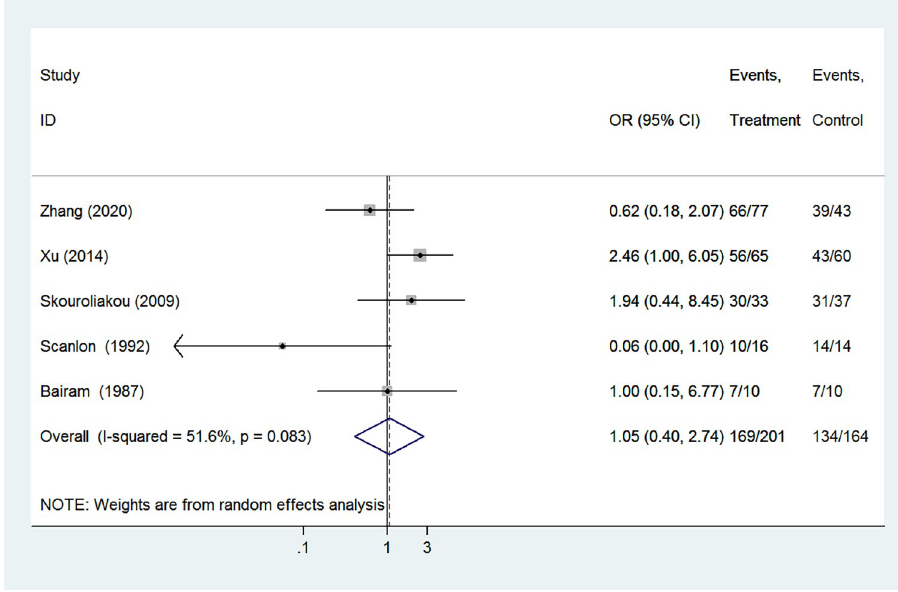
Fig 2. Forest plot of showing the effects of caffeine vs aminophylline on the effective rate of 1–3 days.